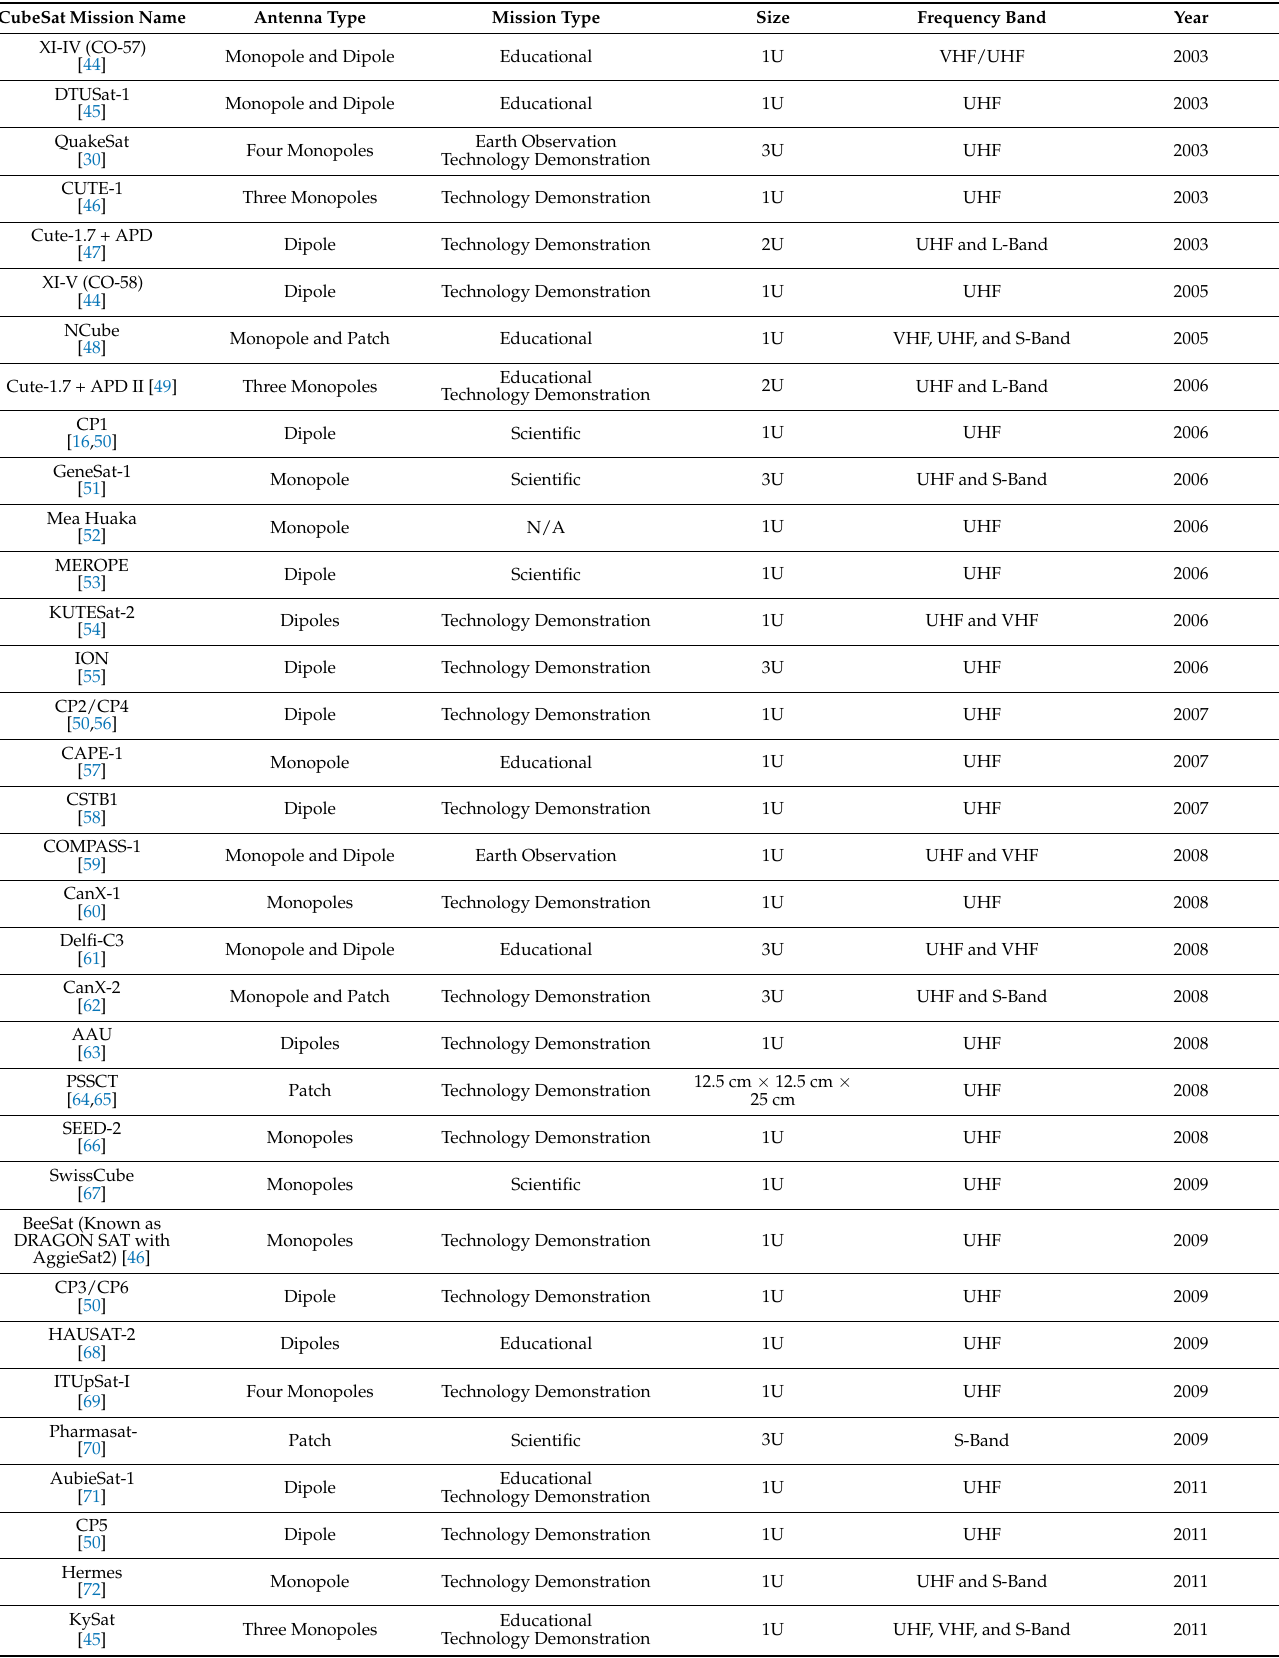
Table 4. Collection of CubeSat missions